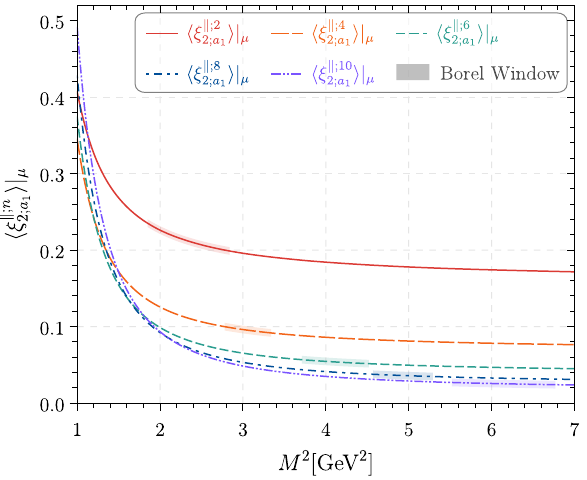
Fig. 2 The relationship curve between parameters α goodness of fit P χ